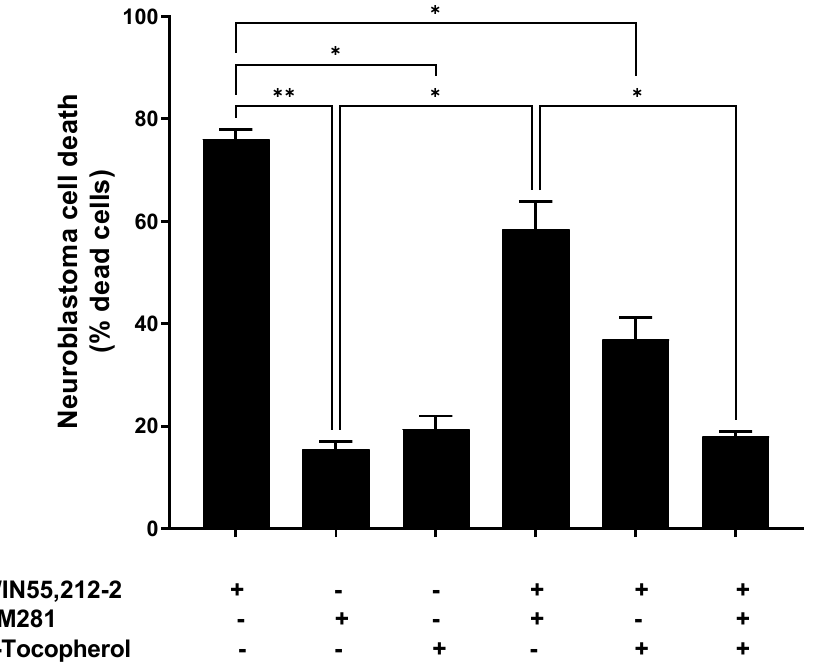
Figure 1. Neuroblastoma cell death upon different treatments with synthetic cannabinoids (3.5 µ g/mL AM281 and 3.5 µ g/mL WIN55,212-2), with or without α -tocopherol pre-treatment (1 µ M). Statistical test Brown Forsythe and Welch ANOVA test was done with a Dunnett post-hoc with α set as 0.05. p -value < 0.05 (*); p -value < 0.01 (**).